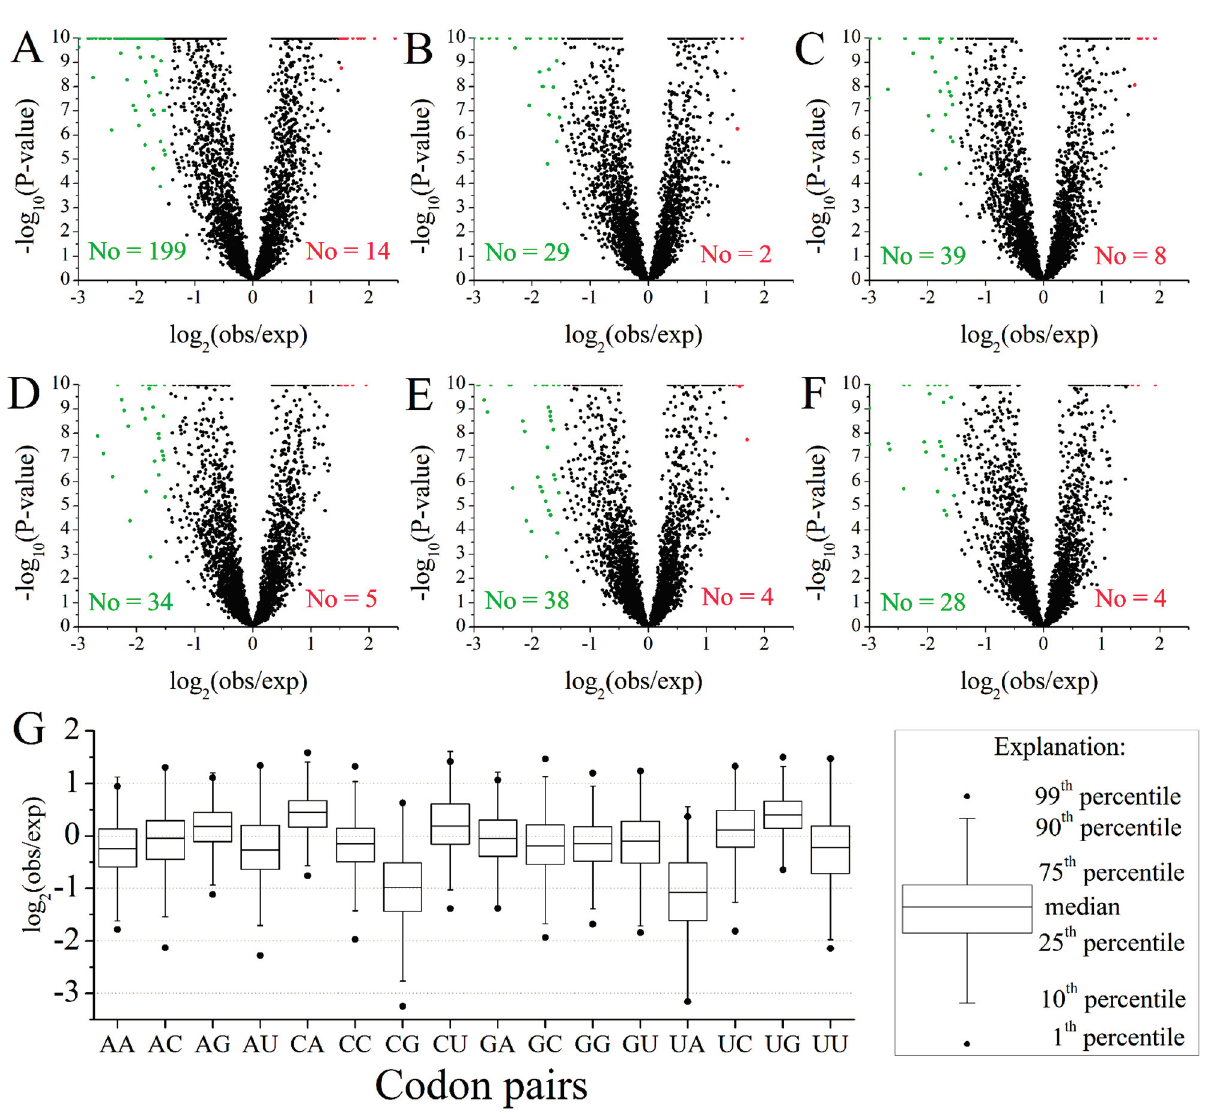
Figure 2. Overview of preferred and avoided codon pairs in M. amblycephala . ( A – F ) The relationship between observed frequency and expected frequency of 3721 (61 × 61) codon pairs (excluding stop codons). The red, green and black spots represent the preferred codon pairs, avoided codon pairs and unbiased codon pairs, respectively. The lowest p -value was set to 1 × 10 − 10 . ( A ) The ratio of observed frequency to expected frequency for neighboring codon pairs; The ratio of observed frequency to expected frequency for codon pairs separated by one ( B ); two ( C ); three ( D ); four ( E ) and five ( F ) intervening codons; ( G ) Distribution of the ratio of observed frequency to expected frequency for different neighboring codon pairs. The X axis shows the dinucleotide at the junction of neighboring codon